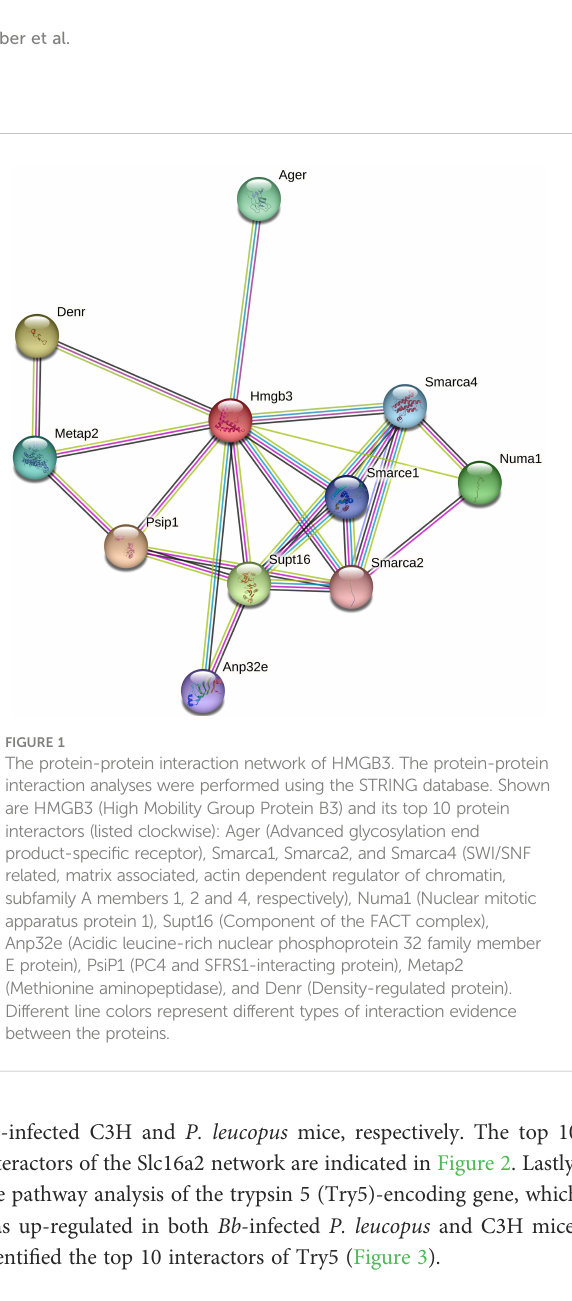
Bb -infected C3H and P. leucopus mice, respectively. The top 10